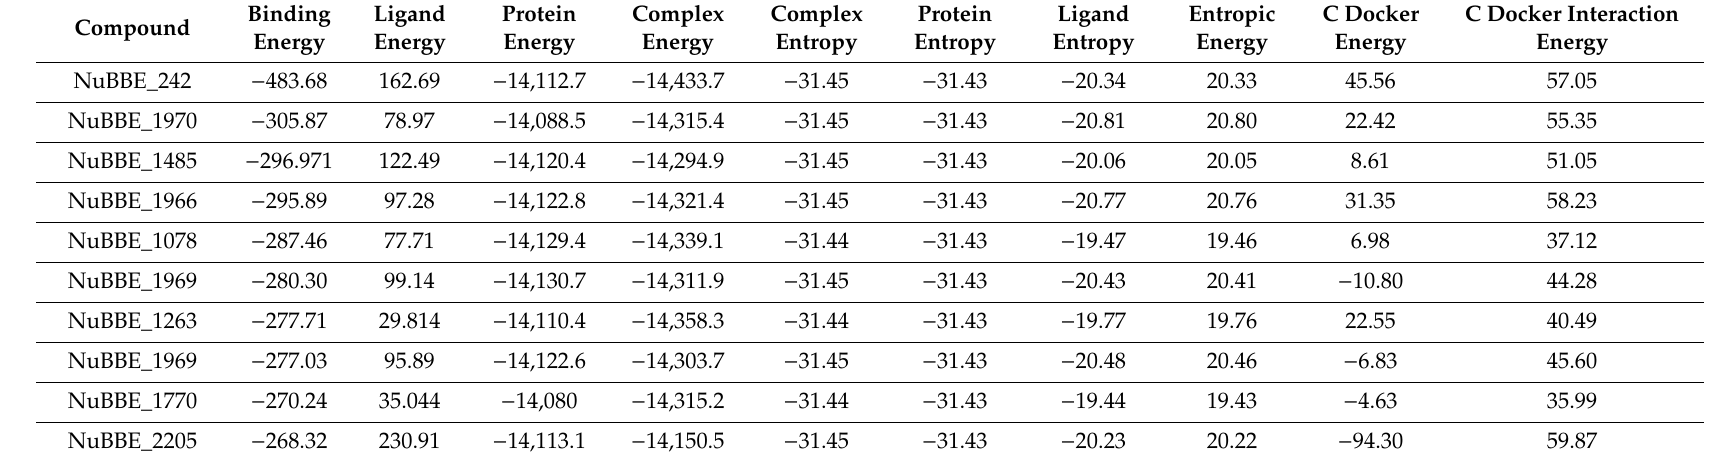
Table 4. Top ten screened compounds based on binding-energy estimation by DS